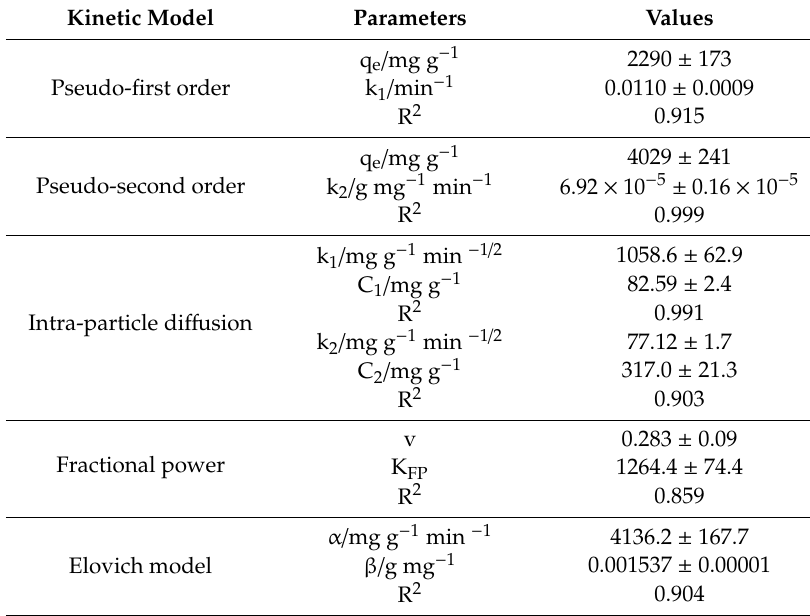
Figure 11. Pseudo-first order plot for the uptake of DOX on MWCNTs ( a ), pseudo-second order plot for the uptake of DOX on MWCNTs ( b ), intra-particle diffusion model plot for the uptake of DOX on MWCNTs ( c ), fractional power model for the uptake of DOX on MWCNTs ( d ), the Elovich plot for the uptake of DOX on MWCNTs ( e ). Data are presented as mean ± SD ( n = 3). Table 3. List of parameters obtained from the kinetic models for the adsorption of DOX on modified MWCNTs.